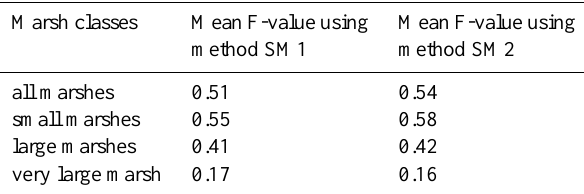
Table 5. Mean F-values for all marshes and for the three surface area classes. Marsh classes Mean F-value